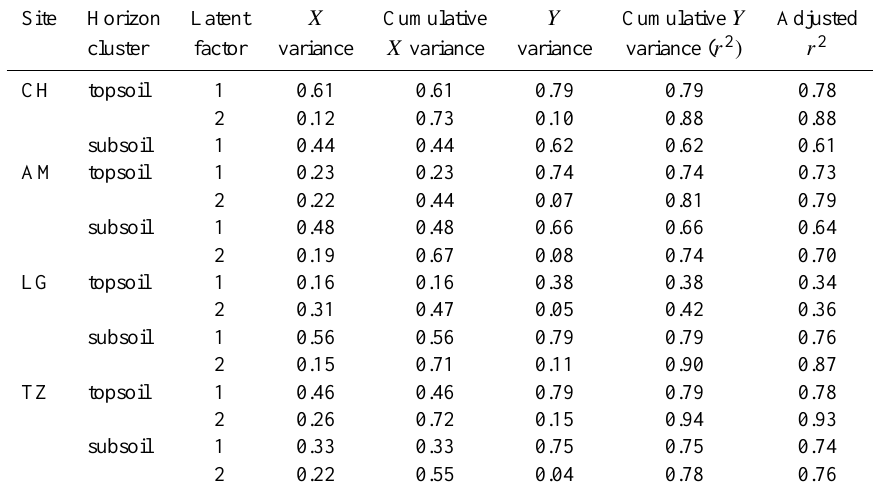
Table 3. Results from the PLSR analysis between HF-OC and various mineral parameters. The PLSR factors (latent factors) are given in descending order of importance and the goodness of fit of the model is indicated by regression coefficients for the response variable (cumulative Y variance).